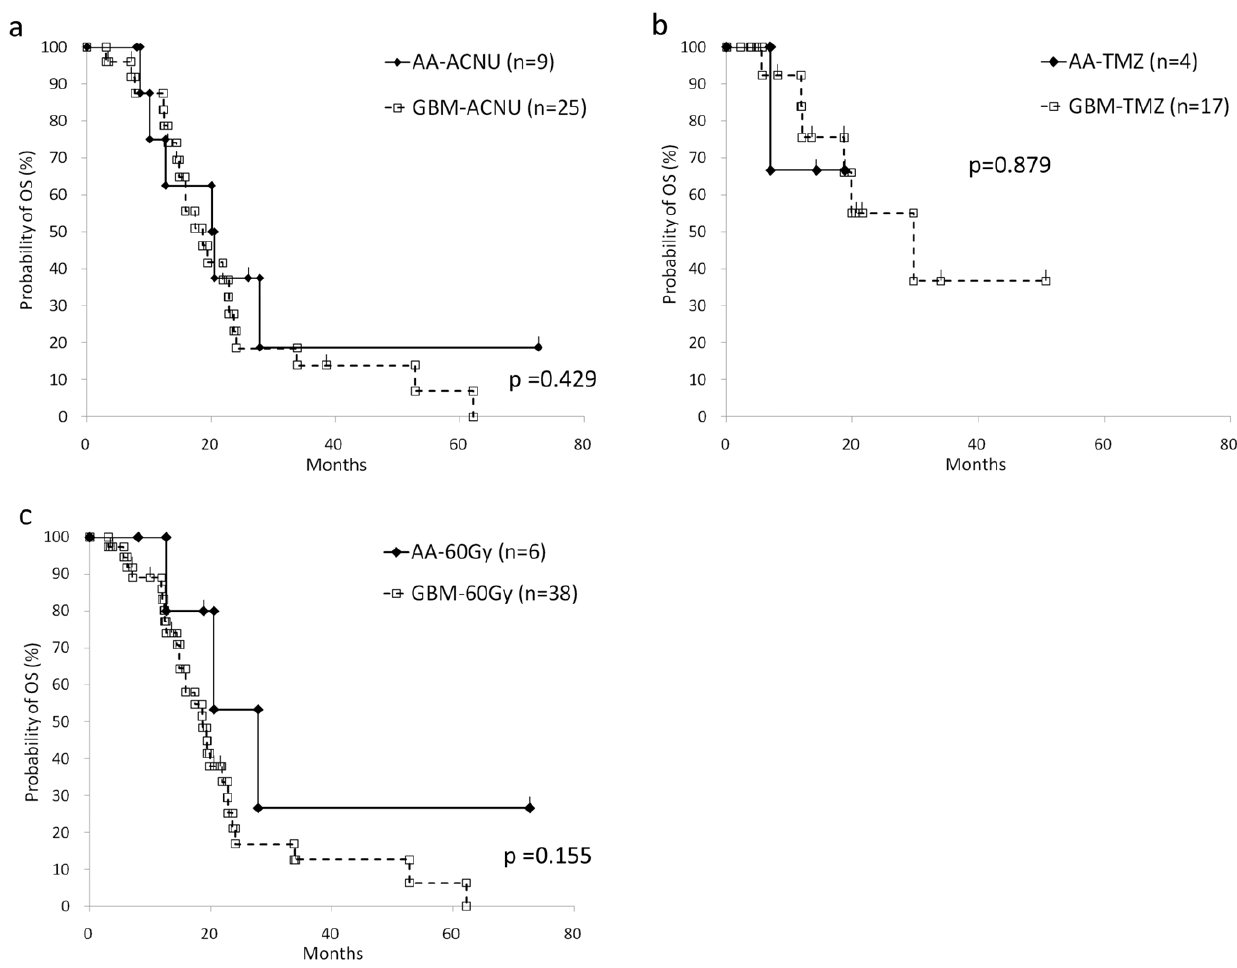
Figure 4. Overall survival analysis of AA and GBM according to the treatment variations. The graph shows comparison of OS between AA and GBM patients who underwent Nimustine hydrochloride (ACNU) - based chemotherapy (a), Temozolomide (TMZ) - based chemotherapy (b), and 60 Gy of radiation therapy (c). There is no statistical siginificance.